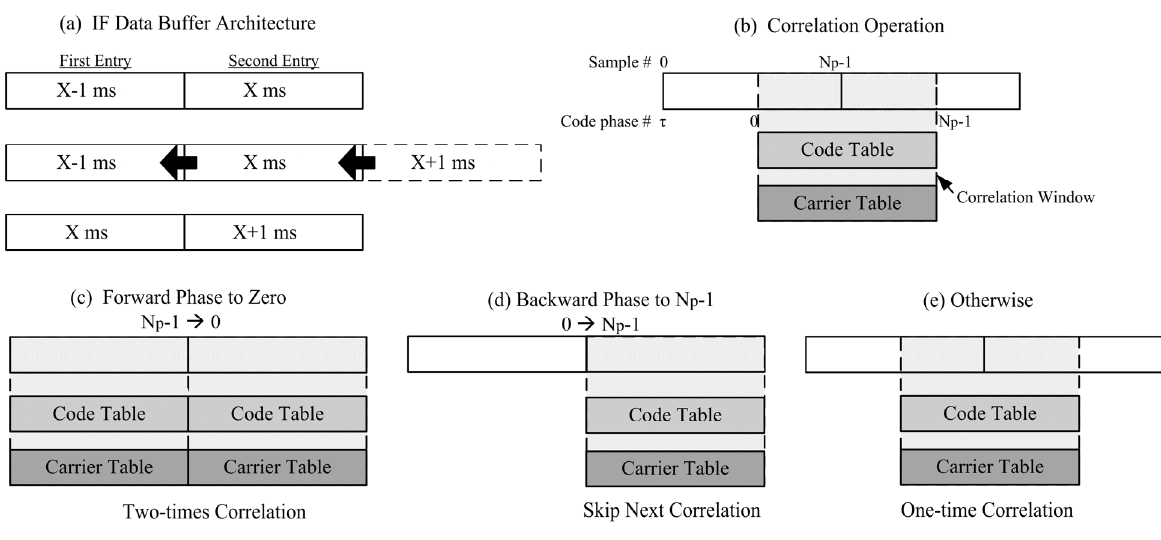
correlation operation which avoid performing correlation with data bit